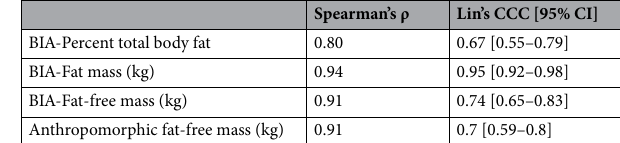
Table 2. Spearman correlations and Lin’s concordance correlation coefficients (CCC) between bioimpedance (BIA) and anthropomorphic body composition measurements relative to dual X-ray absorptiometry (DXA). All p-values were <